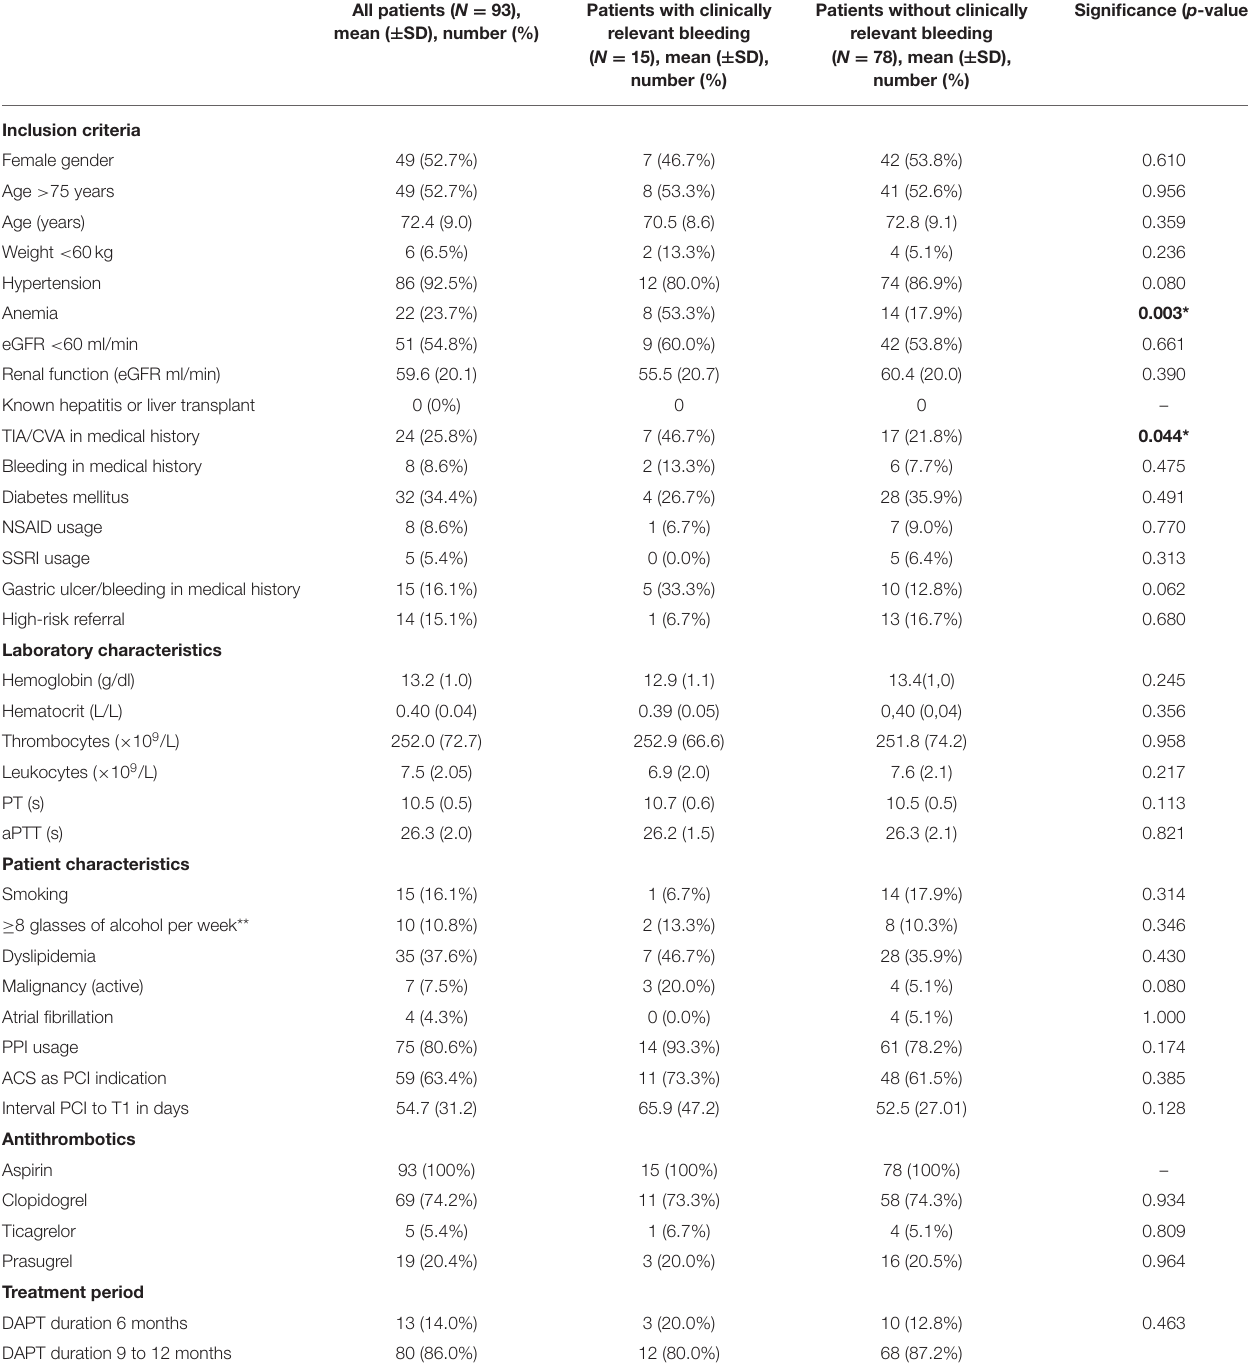
TABLE 1 | Baseline